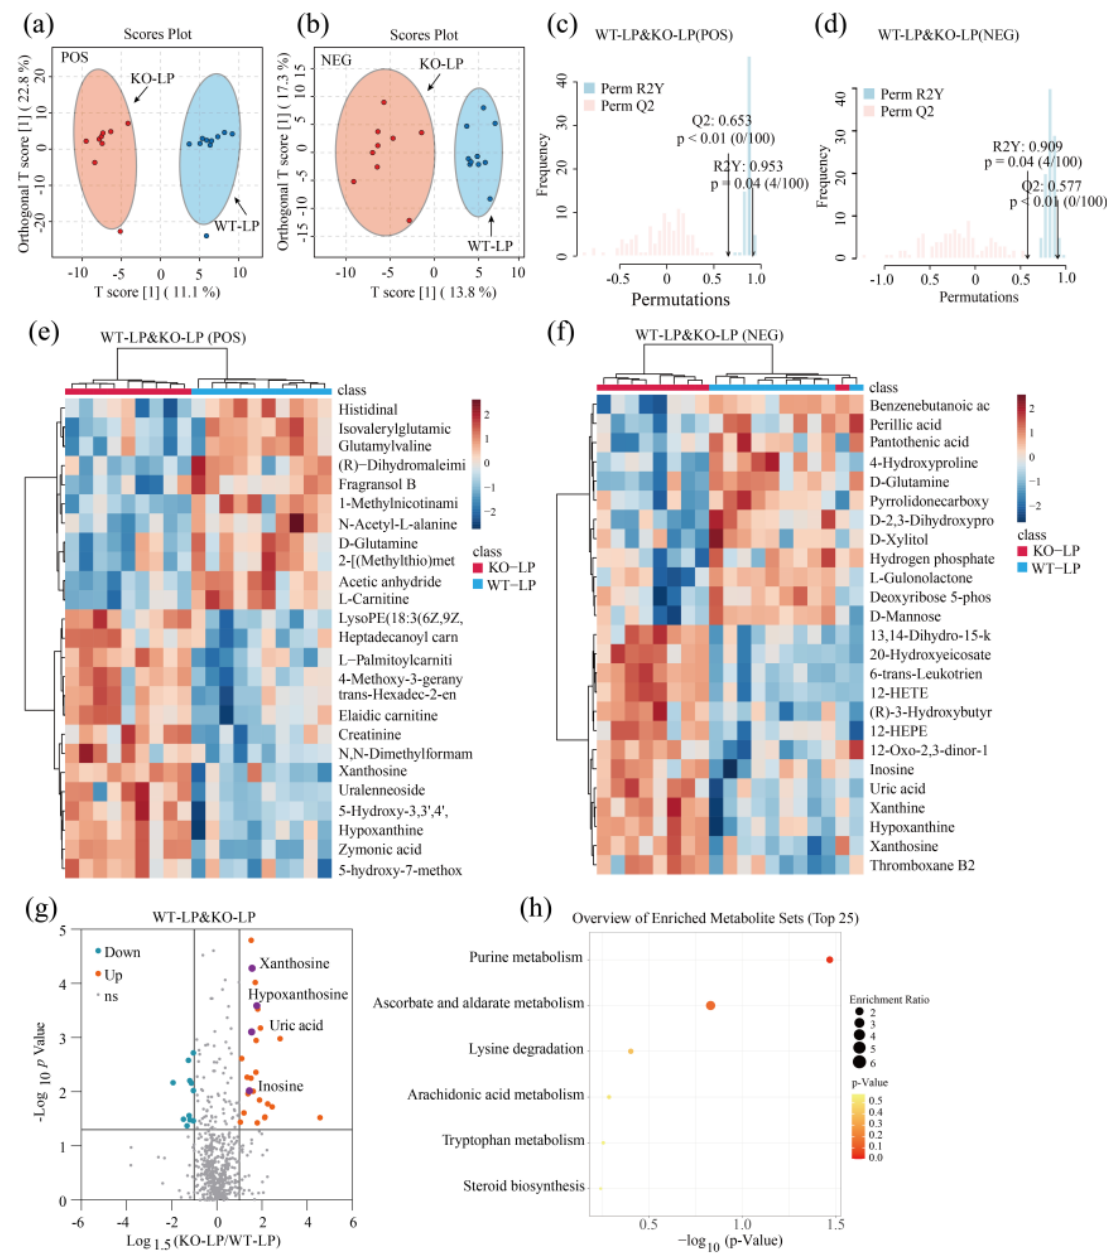
Figure 4. Knockout of GPRC6A altered the metabolic profile of mice fed 10% dietary protein. ( a ) Volcano plot shows the differential metabolites between WT–LP and KO–LP mice; the vertical axis represents the p -value ( − log 10 p -value), and the horizontal axis represents the fold change (Log 1.5 FC) under NEG mode, where FC is defined as the ratio of KO–LP to WT–LP. ( b ) Heatmap based on p -values under NEG mode (Top 25 are presented). ( c ) Volcano plot shows the differential metabolites between WT–NP and KO–NP mice; the vertical axis represents p -value ( − log 10 p -value), and the horizontal axis represents the fold change (Log 1.5 FC) under POS mode, where FC is defined as the ratio of KO–LP to WT–LP. ( d ) Heatmap based on p -values under POS mode (Top 25 are presented). ( e , f ) Heatmap of metabolites with the most significant differences based on p − values (Top 25). ( g ) Volcano plot shows the differential metabolites between WT − LP and KO − LP; the vertical axis represents the p − value ( − log 10 p − value), and the horizontal axis represents the fold change (Log1.5FC), where FC is defined as the ratio of levels in KO − LP to WT − LP. ( h ) Overview of enriched metabolite sets (Top 25 are presented); the horizontal axis represents p -values ( − log 10 p -value); enrichment ratio was defined as the ratio of observed hits to expected